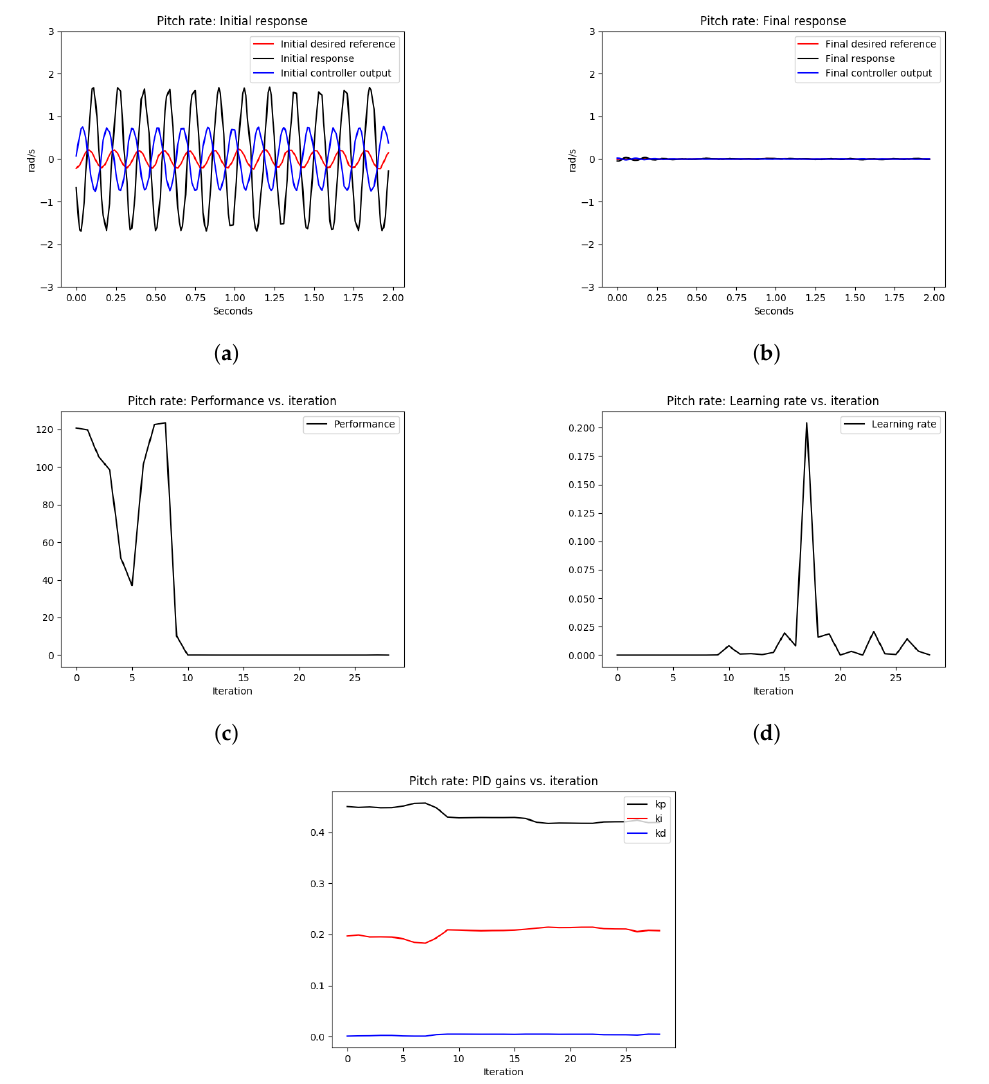
Figure 9. The tuning process of the pitch rate PID controller during hovering. The quadrotor starts with an oscillating behavior due to poorly tuned PID gains. Eventually, the angular rate loops are stabilized after the real-time tuning process. ( a ) signals before tuning, ( b ) signals after tuning, ( c ) performance error V ( E ) over iterations, ( d ) learning rate α over tuning iterations, ( e ) PID gains.